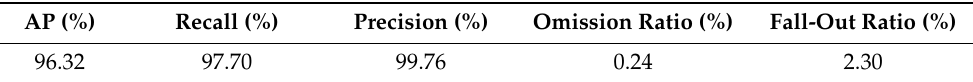
Table 3. Results after using K-means ++ clustering.